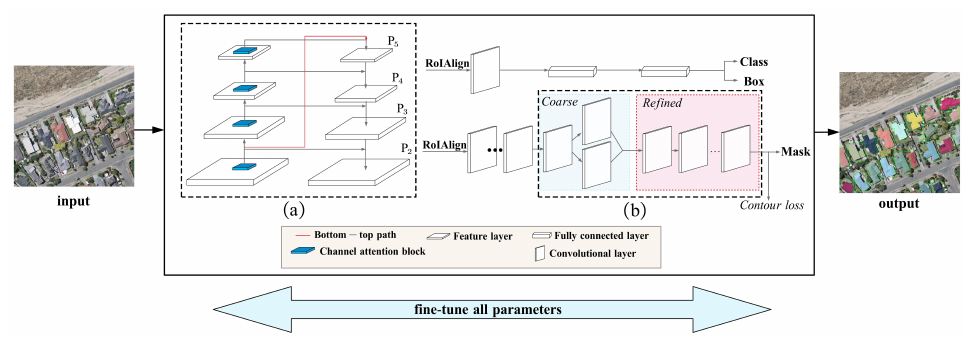
Figure 2. Overview of the proposed network for building instance extraction: ( a ) AFPN sub-network, ( b ) coarse-to-fine contour sub-network.